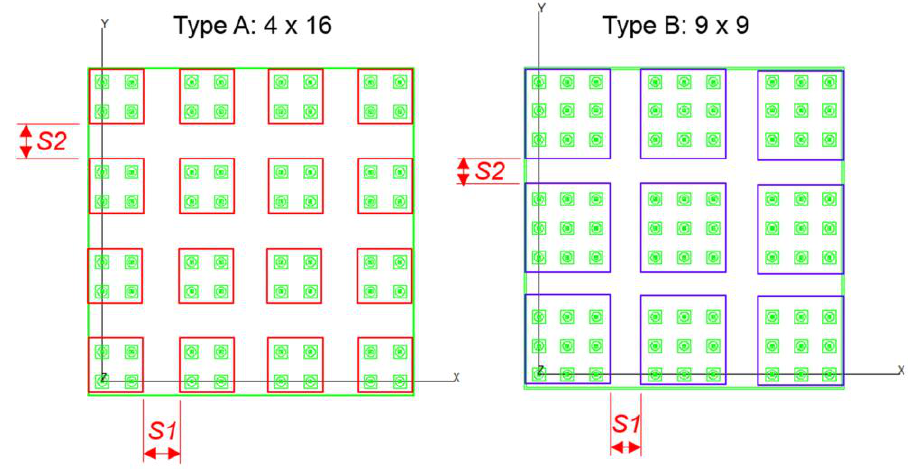
Figure 4. The design variables S1 and S2 .